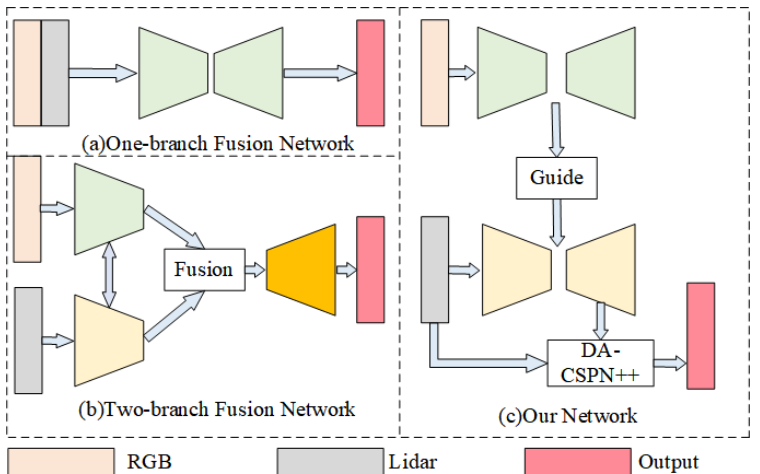
Figure 1. In order to better fuse LiDAR features as well as RGB image features, current depth completion networks mostly use one-branch fusion network ( a ) or two-branch fusion network ( b ). We propose a secondary guidance network ( c ), which aims to fully and efficiently utilize the image as well as LiDAR features to accomplish depth completion more